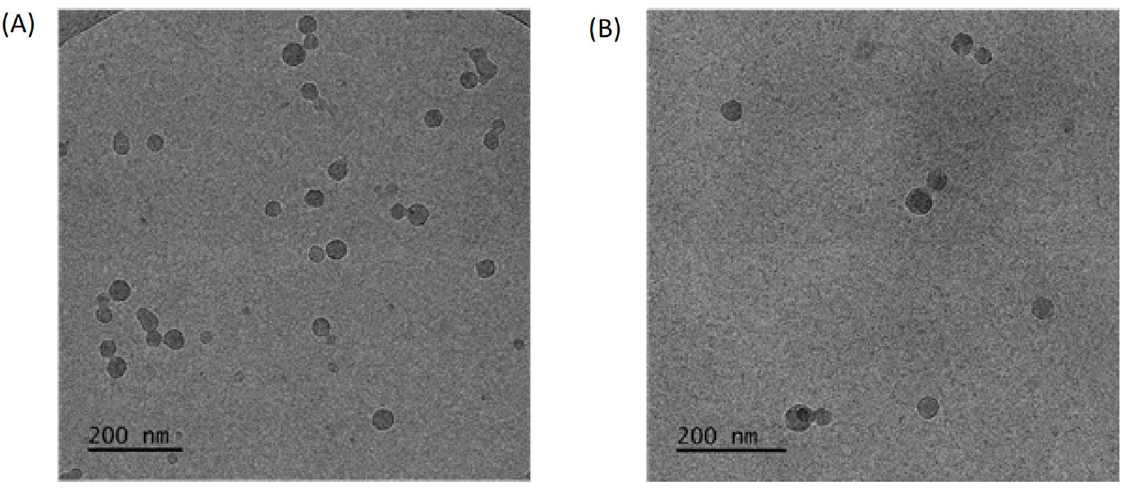
Figure 4. Cryogenic transmission electron microscopy images of P(DMAEMA-co-OEGMA-OH) stars after quaternization ( A ) sample SCQ 2 ) ( B ) sample SCQ 8 .